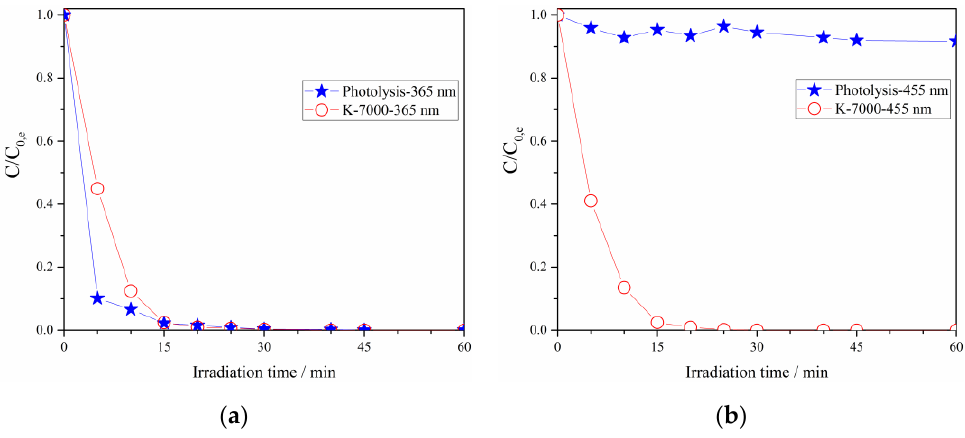
Figure 1. Photocatalytic and photolytic conversions of chlorpromazine upon ( a ) UV(A) and ( b ) visible light irradiation (C 0 : 100 µM-Catalyst: K-7000 (1 g L − 1 ) -Irradiation wavelengths: 365 and 455 nm).